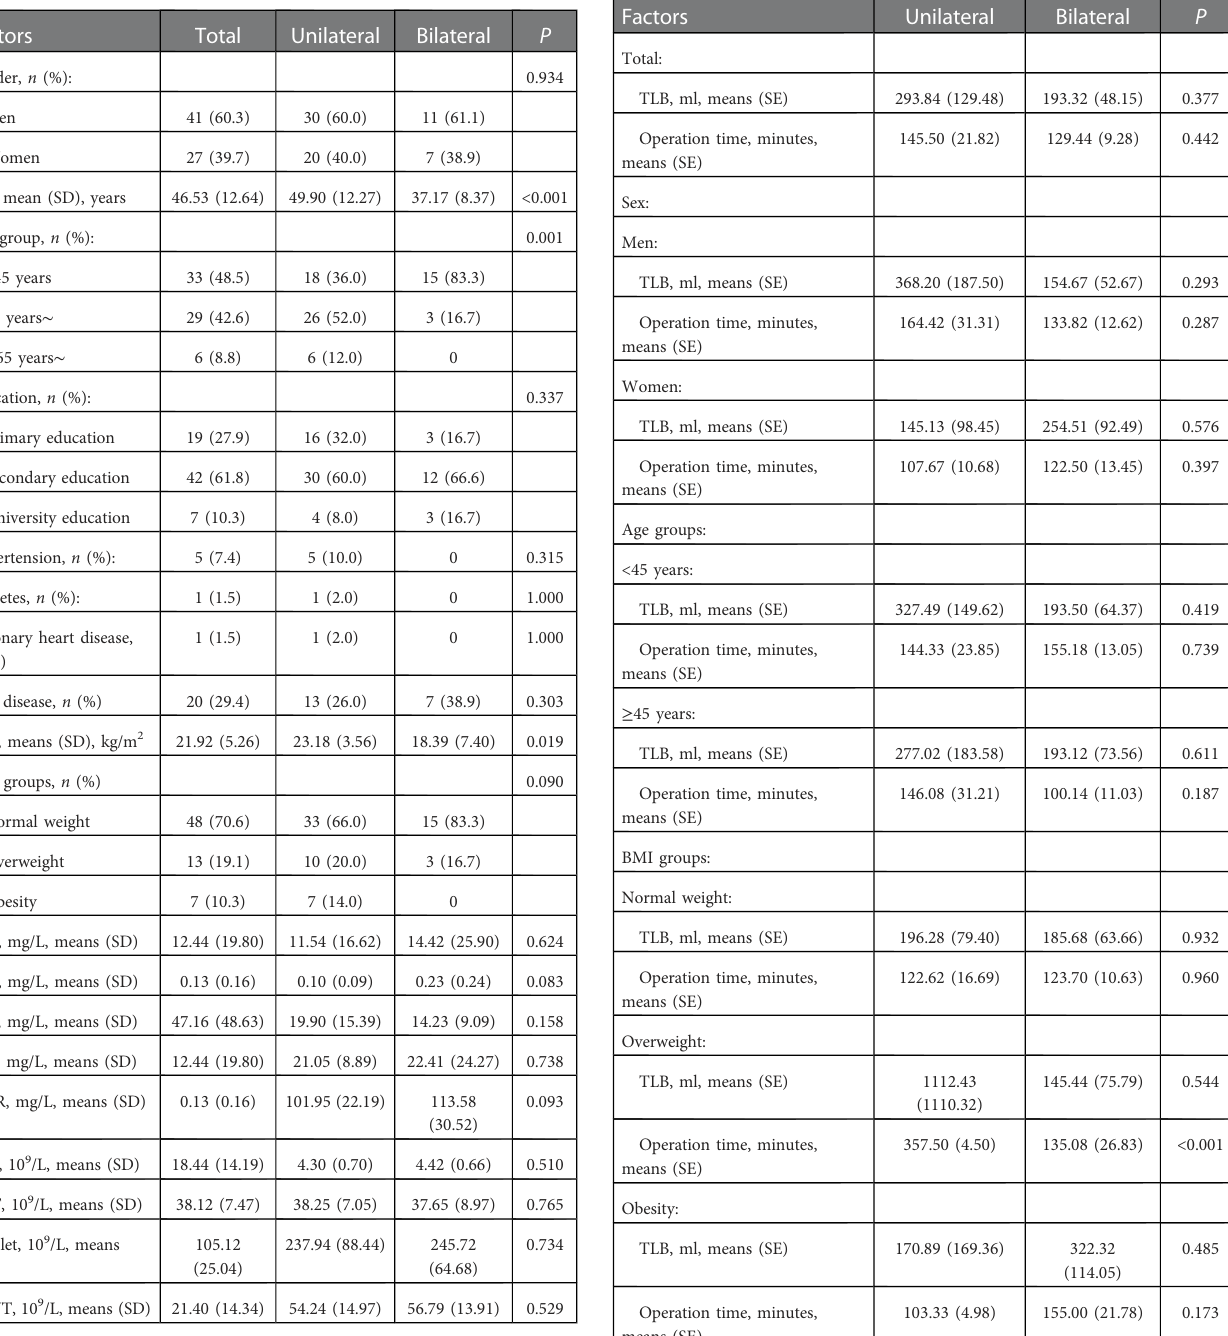
TABLE 1 Baseline characteristic in all patients both in unilateral and bilateral. . Factors Total Unilateral Bilateral P